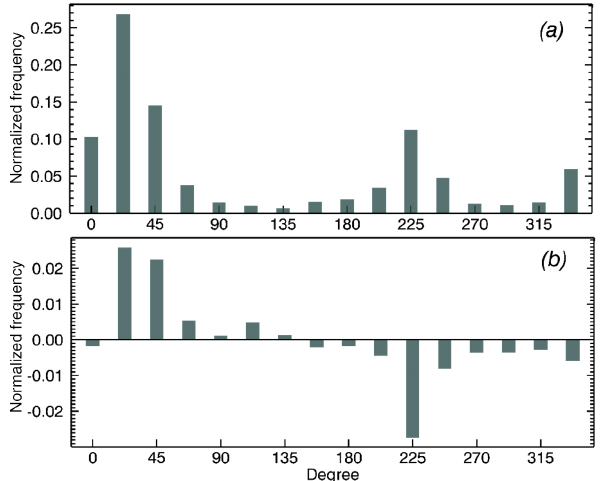
Table 4. DT and NT (KST) in the summer and winter